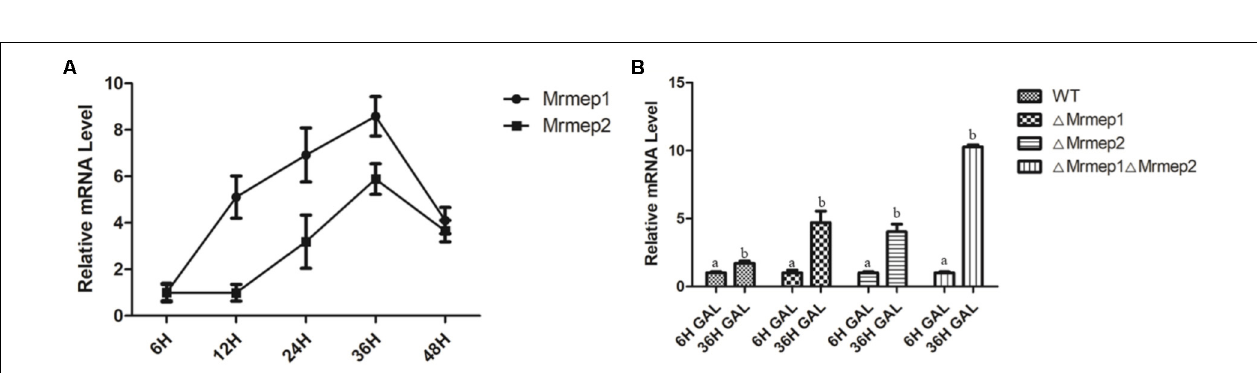
FIGURE 6 | qRT-PCR analysis of the expression levels of different genes in the infection process. (A) During G. mellonella infection with the WT Mr23, we quantified the relative expression of Mrmep1 and Mrmep2 transcript levels in total RNA at 6, 12, 24, 36, and 48 hpi. (B) During the infection of G. mellonella at 36 hpi, the relative expression levels of the gal gene were used to quantify the transcript levels of GAL in the (cid:49) Mrmep1 , (cid:49) Mrmep2 , and (cid:49) Mrmep1 (cid:49) Mrmep2 strains.